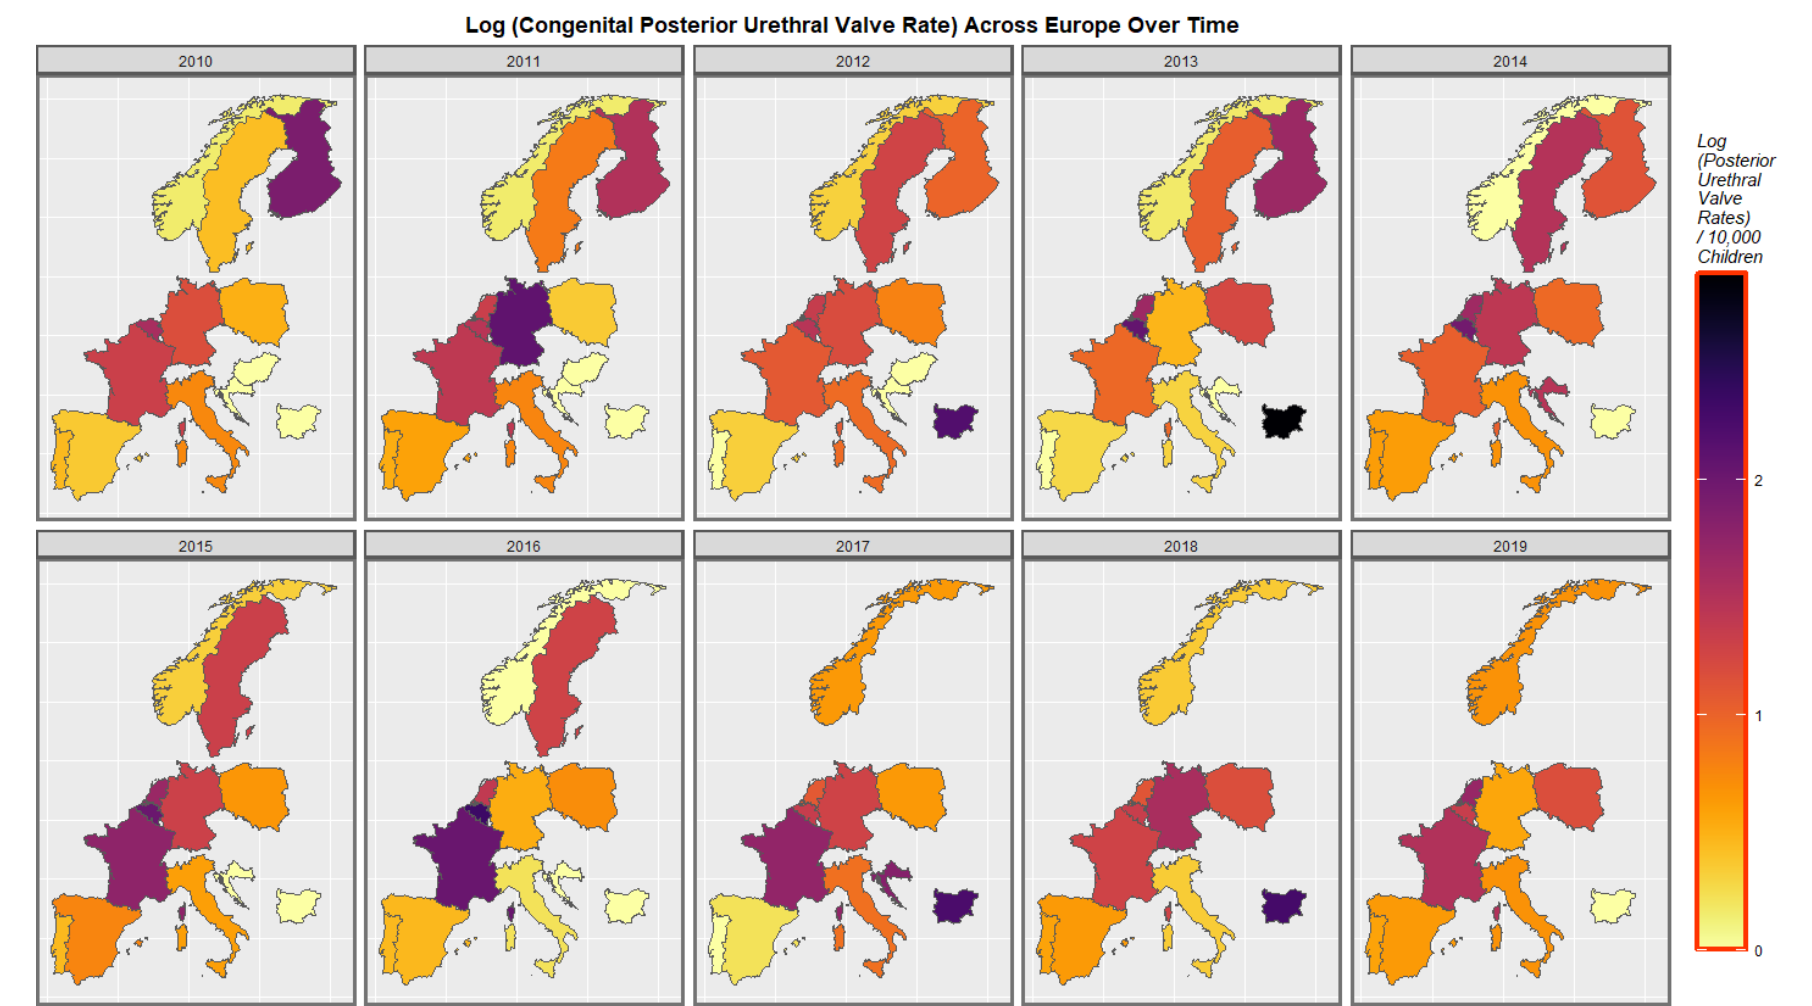
Figure 5. Time sequential map-graph of log (congenital posterior urethral valve rate) across surveyed European nations over time.